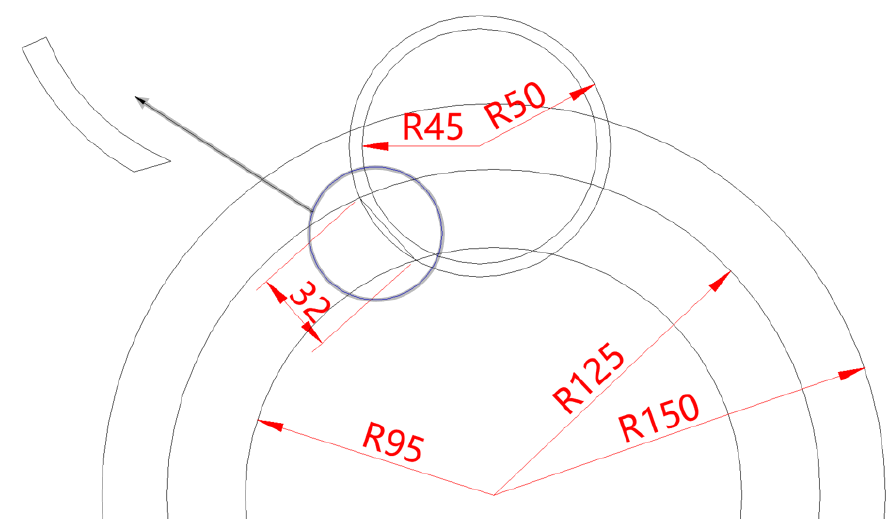
Figure 10. Drawing of the contour of the disturbing tooth.